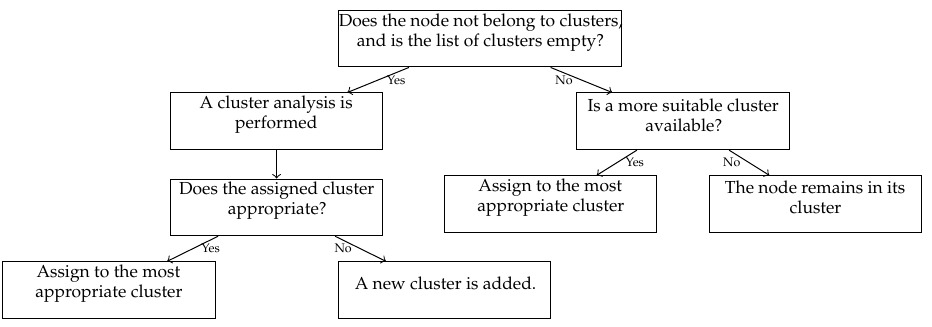
Figure 1. Conditions to be met for cluster assignments.